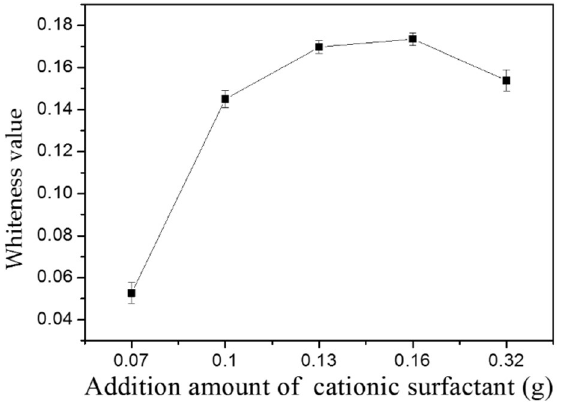
Figure 10. The detergency rate of MMO with different additional amounts of SN.